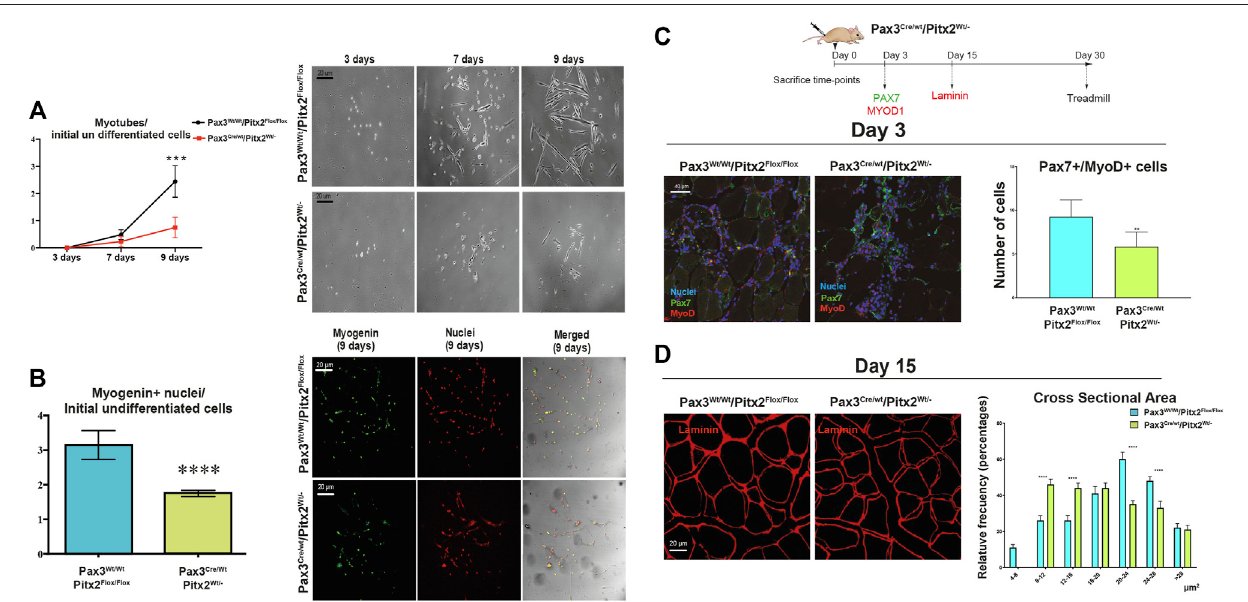
FIGURE 7 | SC differentiation and muscle regeneration are compromised in adult Pax3 Cre/Wt /Pitx2 Wt/- heterozygous mice. (A) Ratio of number of myotubes per initial undifferentiated cells (day 3 of culture) through in vitro differentiation (7 and 9 days of culture) in SC isolated from Pax3 Wt/Wt /Pitx2 Flox/Flox vs . SC from Pax3 Cre/Wt / Pitx2 Flox/, and representative images of in vitro differentiation. (B) Relative values of number of myogenin + nuclei in differentiated cells (day 9 of culture) per initial undifferentiated cells in SC isolated from Pax3 Wt/Wt /Pitx2 Flox/Flox vs . SC from Pax3 Cre/Wt /Pitx2 Flox/, and representative images of myogenin + nuclei. (C) Scheme of CTX injection in the TA of Pax3 Cre/Wt /Pitx2 Wt/Wt and Pax3 Cre/Wt /Pitx2 Wt/- mice and representative image of PAX7 + /MYOD1 + cells at day 3 after cardiotoxin injection in tibialis anterior muscle (TA). Percentage of PAX7 + /MYOD1 + cells is shown. (D) Representative images of LAMININ staining in tibialis anterior (TA) muscles of Pax3 Cre/Wt / Pitx2 Wt/- heterozygous mice vs. Controls Pax3 Cre/Wt /Pitx2 Wt/- mice at day 15 after cardiotoxin injection. Cross-sectional area is shown.* p < 0.0.1, *** p < 0.001, **** p < 0.0001 ( n = at least 3 mice per condition).